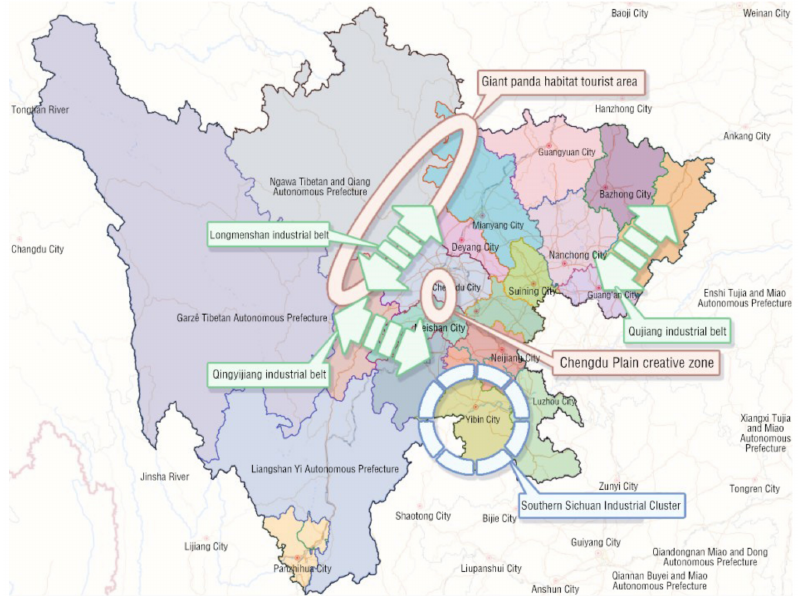
Figure 29. Industrial development pattern planning of “a group, two areas, and three belts” for the bamboo scenic line in Sichuan